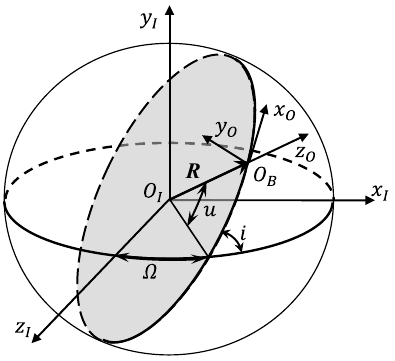
Figure 5: Axes of IRF and ORF.